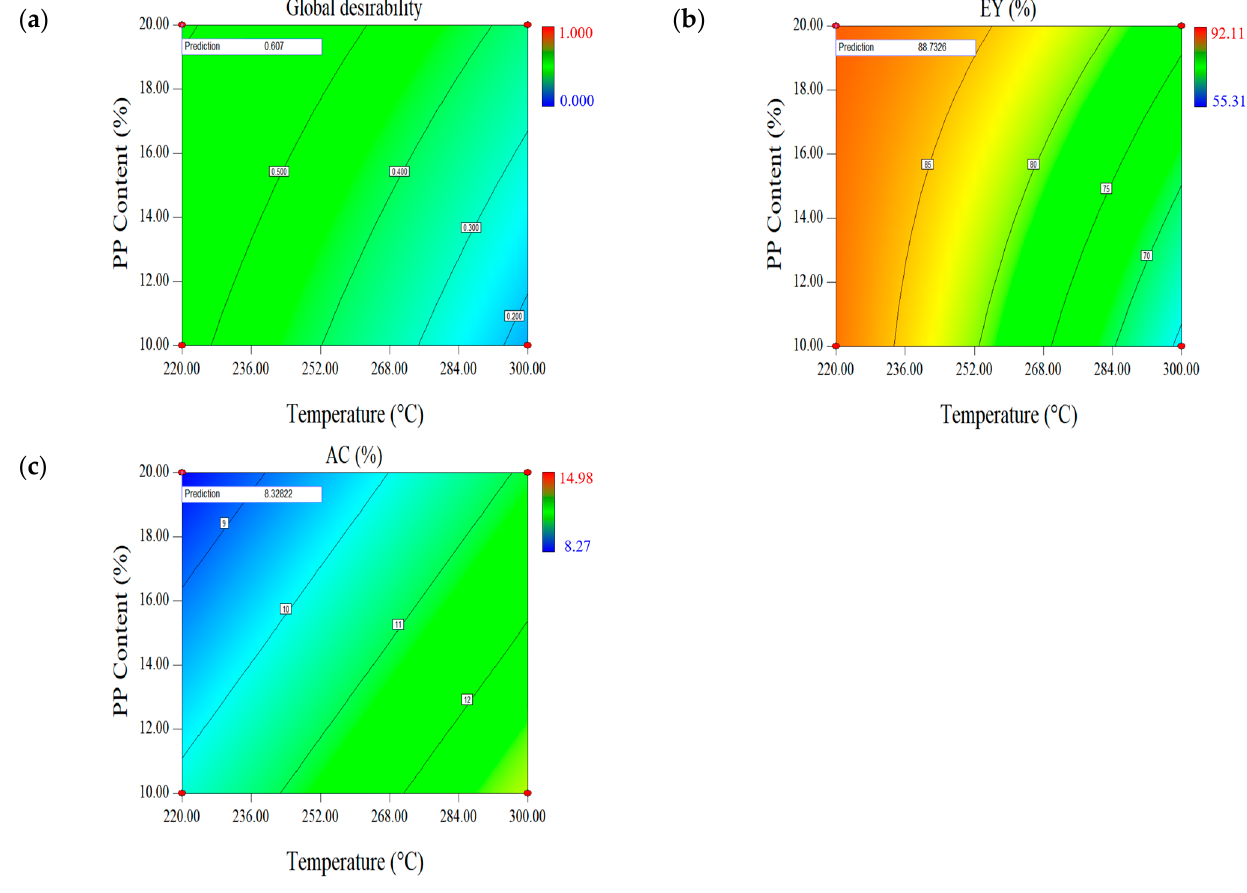
Figure 3. Contour plots for global desirability and response set EY-AC: ( a ) Global desirability, ( b ) energy yield (EY), and ( c ) ash content (AC). Table 6. Comparison of various types of biomass